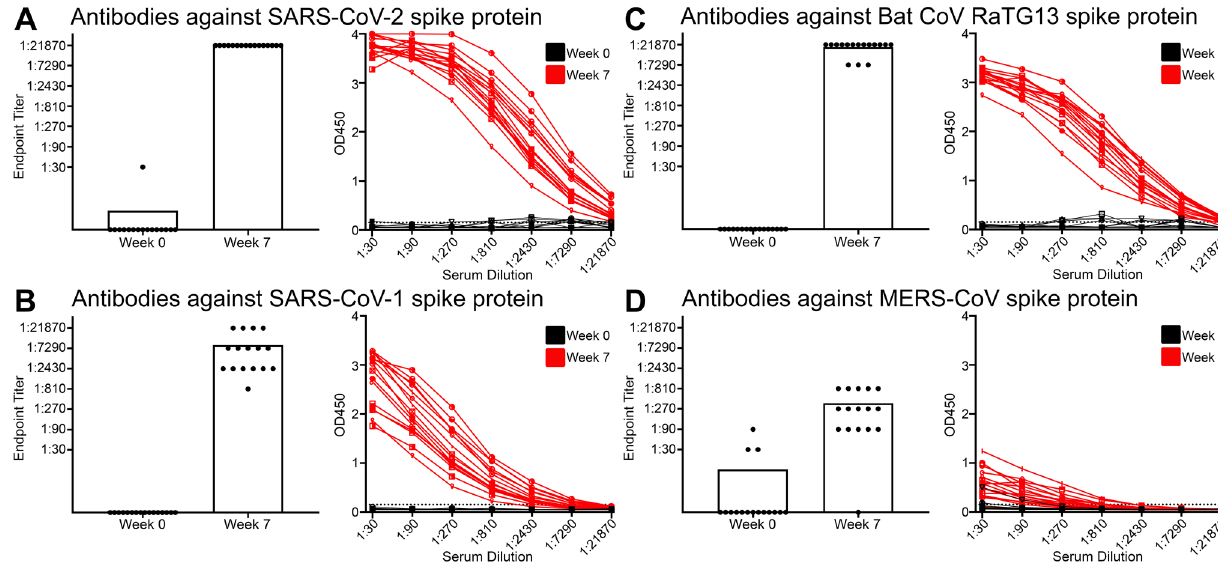
Figure 2. Vaccination targeting SARS-CoV-2 also elevated antibody responses to other related viruses. ( A ) Bar and line graph of antibody responses obtained by ELISA at different plasma dilutions to SARS-CoV-2 spike protein, before the Pfizer-BioNTech BNT162b2 vaccine was administered (Week 0) and after both doses (Week 7), using plasma from patients with no history of SARS-CoV-2 infection, n = 16 individuals. ( B ) Bar and line graph of antibody responses obtained by ELISA at different plasma dilutions to SARS-CoV-1 spike protein, before the Pfizer-BioNTech BNT162b2 vaccine was administered (Week 0) and after both doses (Week 7), using plasma from patients with no history of SARS-CoV-2 infection, n = 16 individuals. ( C ) Bar and line graph of antibody responses obtained by ELISA at different plasma dilutions to Bat CoV RaTG13 spike protein, before the Pfizer-BioNTech BNT162b2 vaccine was administered (Week 0) and after both doses (Week 7), using plasma from patients with no history of SARS-CoV-2 infection, n = 16 individuals. ( D ) Bar and line graph of antibody responses obtained by ELISA at different plasma dilutions to MERS-CoV spike protein, before the Pfizer-BioNTech BNT162b2 vaccine was administered (Week 0) and after both doses (Week 7), using plasma from patients with no history of SARS-CoV-2 infection, n = 16 individuals. Endpoint titers are designated by the most dilute plasma concentration detected above the minimum threshold of the background OD450 multiplied by 3. Dots are representative of individual samples. Bars are representative of the mean of all